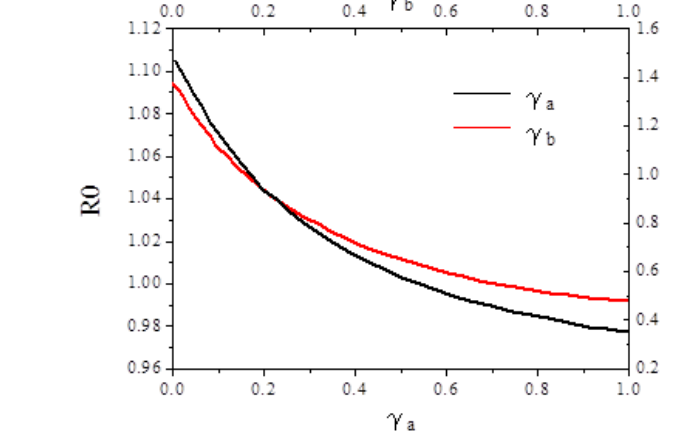
Figure 4. The effect of the degree of immunity of wild ( γ a ) and domestic ( γ b ) dogs on